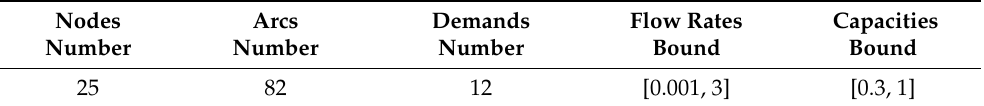
Table 1. Medium problem instances’ parameters.